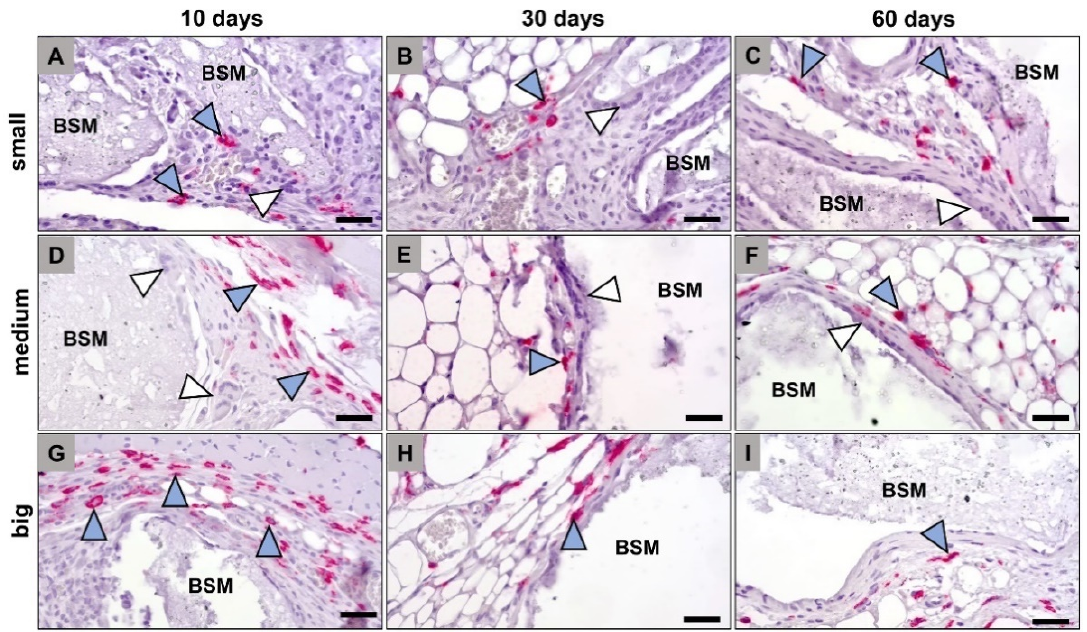
Figure 2. Exemplary histological images of anti-inflammatory (CD163-positive) macrophages (blue arrowheads) within the implant beds of the differently sized bone substitute materials (BSM), i.e., the small BSM granules ( A – C ), the medium- sized BSM granules ( D – F ), and the big BSM granules ( G – I ). CT = connective tissue, white arrowheads = CD163-negative multinucleated giant cells (CD163-immunostainings, 400 × magnifications, scalebars = 50 µ m).